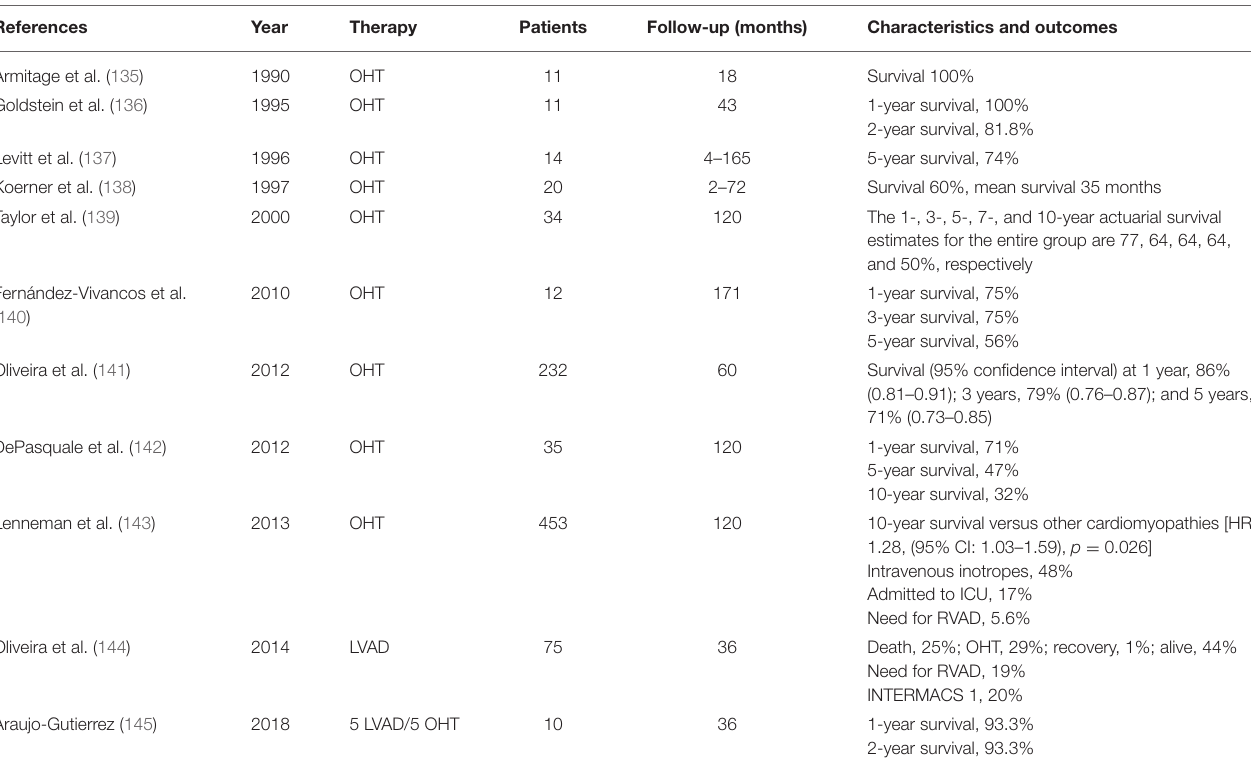
TABLE 1 | Characteristics of the studies on advanced therapies for HF in